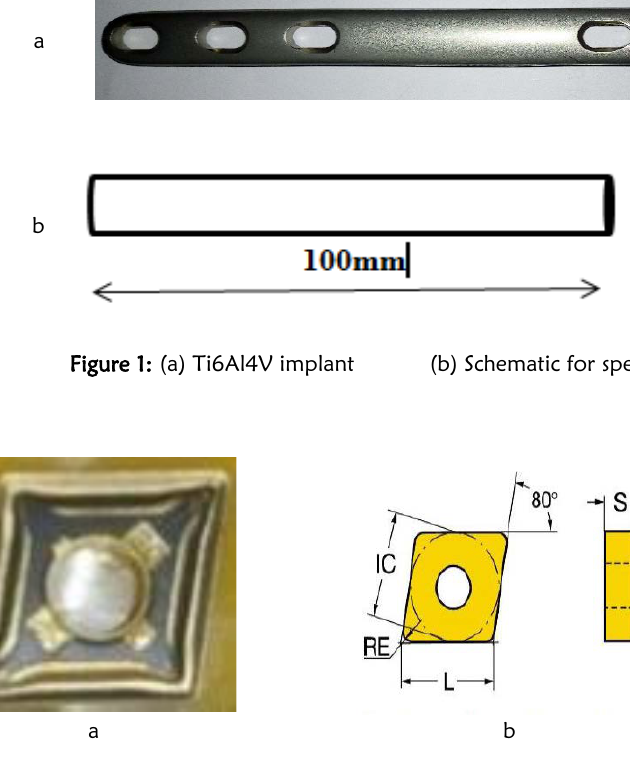
Figure 2: (a): PVD Coated Carbide Insert (b) Schematic for